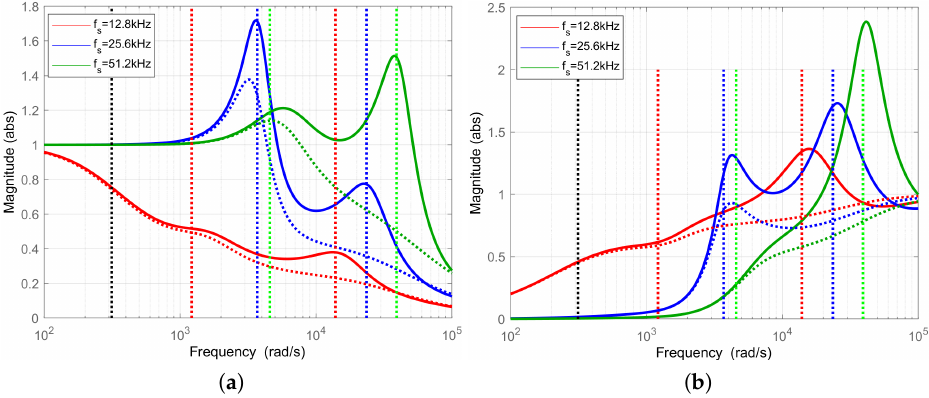
Figure 19. ( a ) Complementary sensitivity T ( ω ) and ( b ) S ( ω ) of the closed-loop for the load mode.